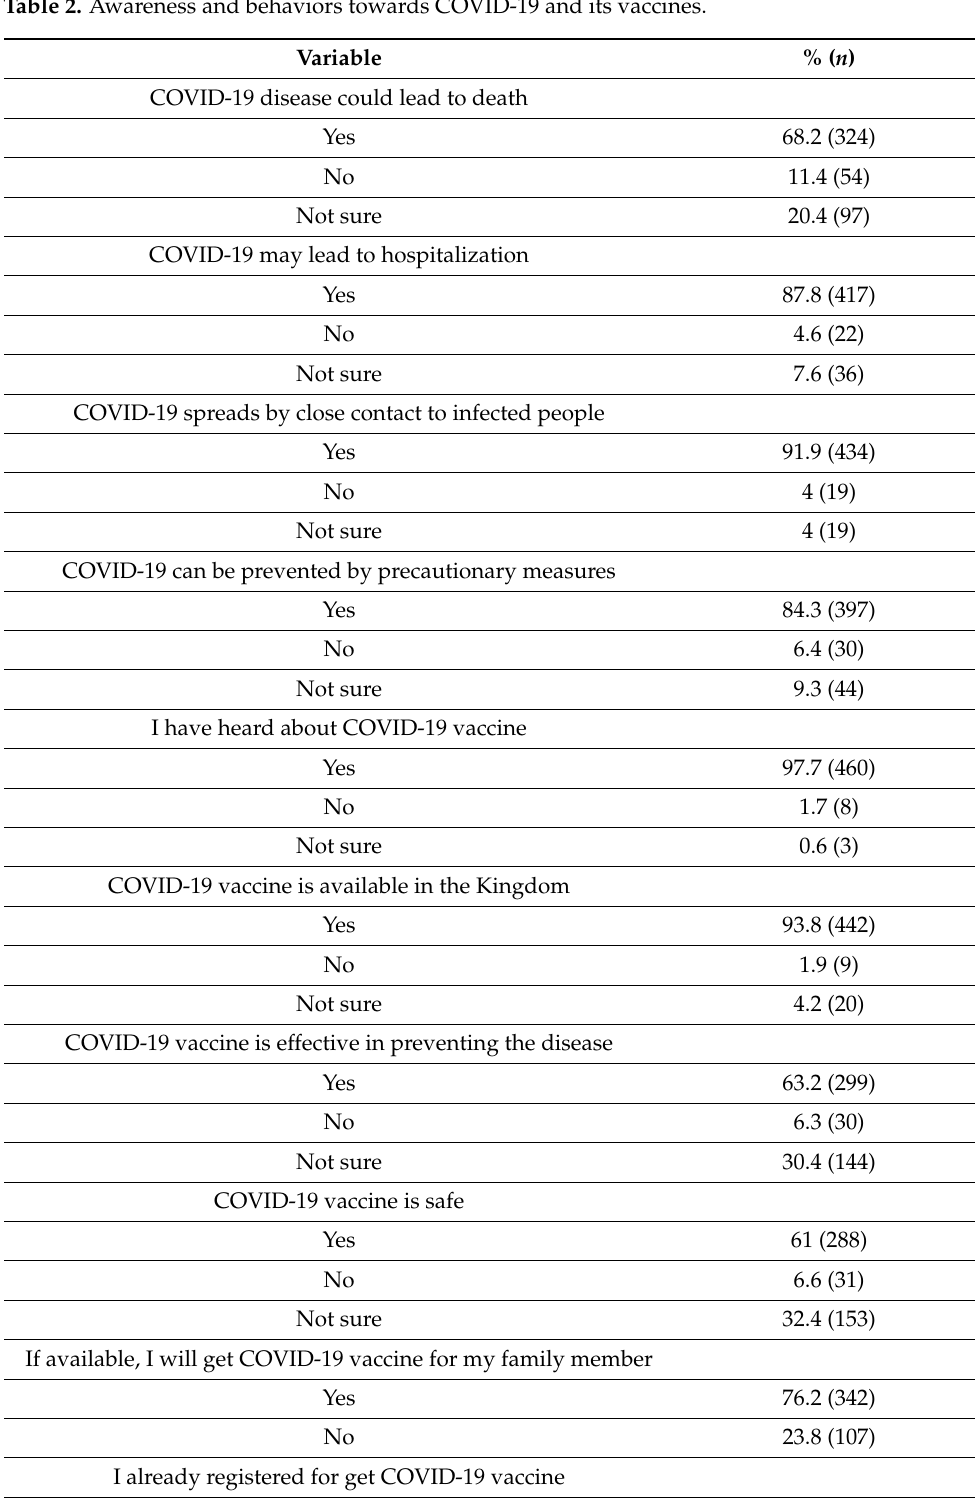
Table 2. Awareness and behaviors towards COVID-19 and its